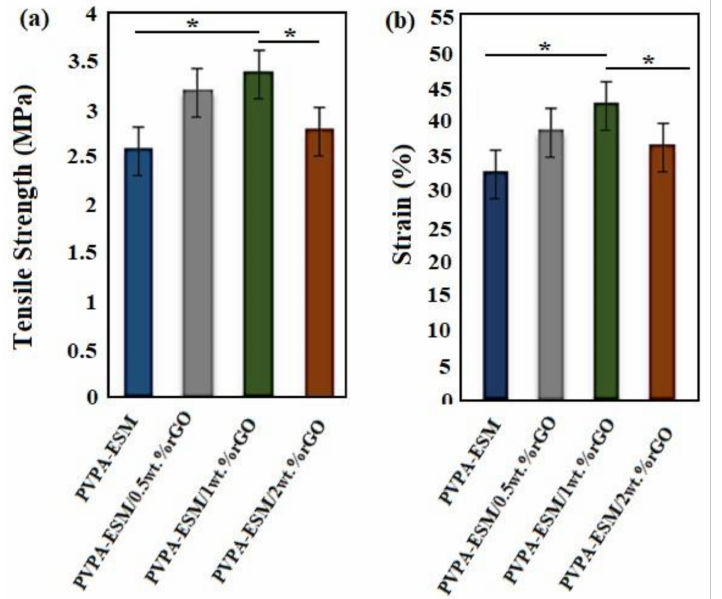
Figure 6. ( a ) Tensile strength, and ( b ) strain at break of PVPA—ESM/x wt.% rGO nanofibers with various rGO concentrations (x = 0, 0.5, 1 and 2 wt.%) ( p * < 0.05).